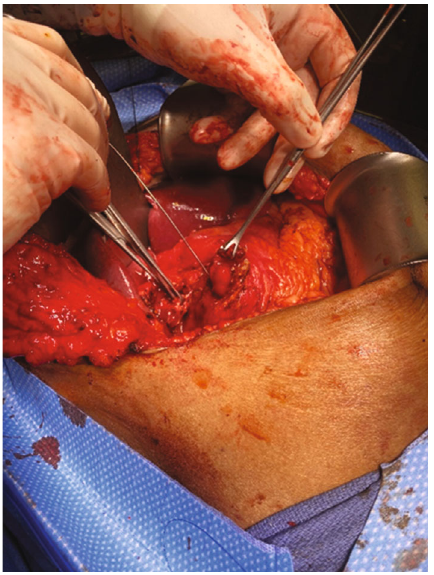
Figure 7: Intraop picture of the duodenal fi stula before